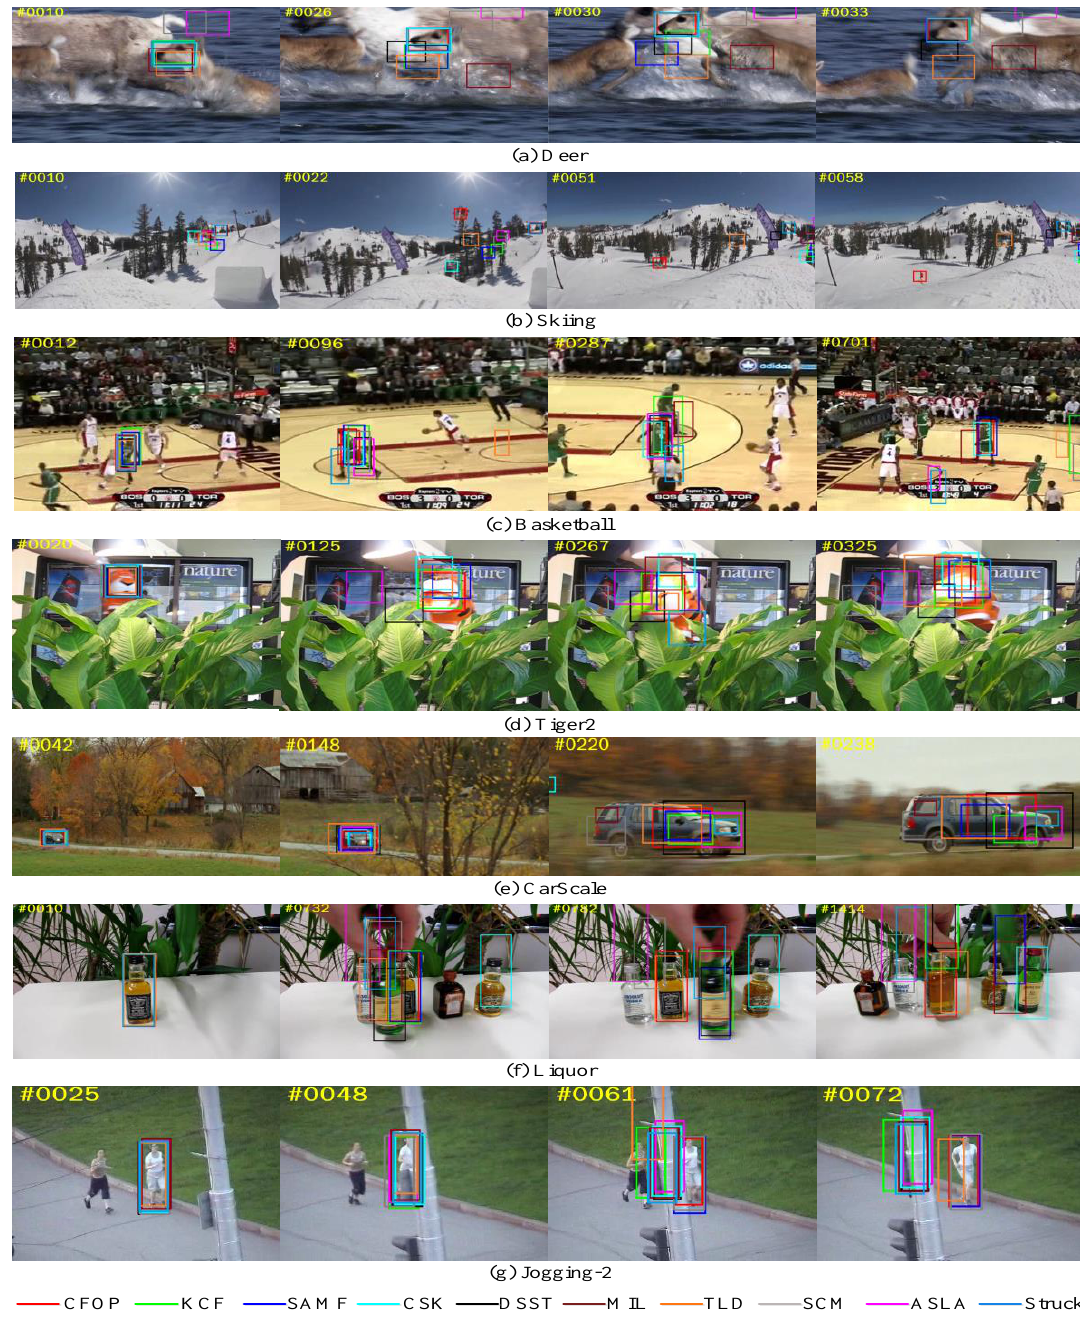
Figure 8. Compared qualitative results of CFSA tracker with nine other trackers on seven challenging sequences, i.e., ( a ) Deer , ( b ) Skiing , ( c ) Basketball , ( d ) Tiger 2, ( e ) CarScale , ( f ) Liquor and ( g ) Jogging -2 sequence.